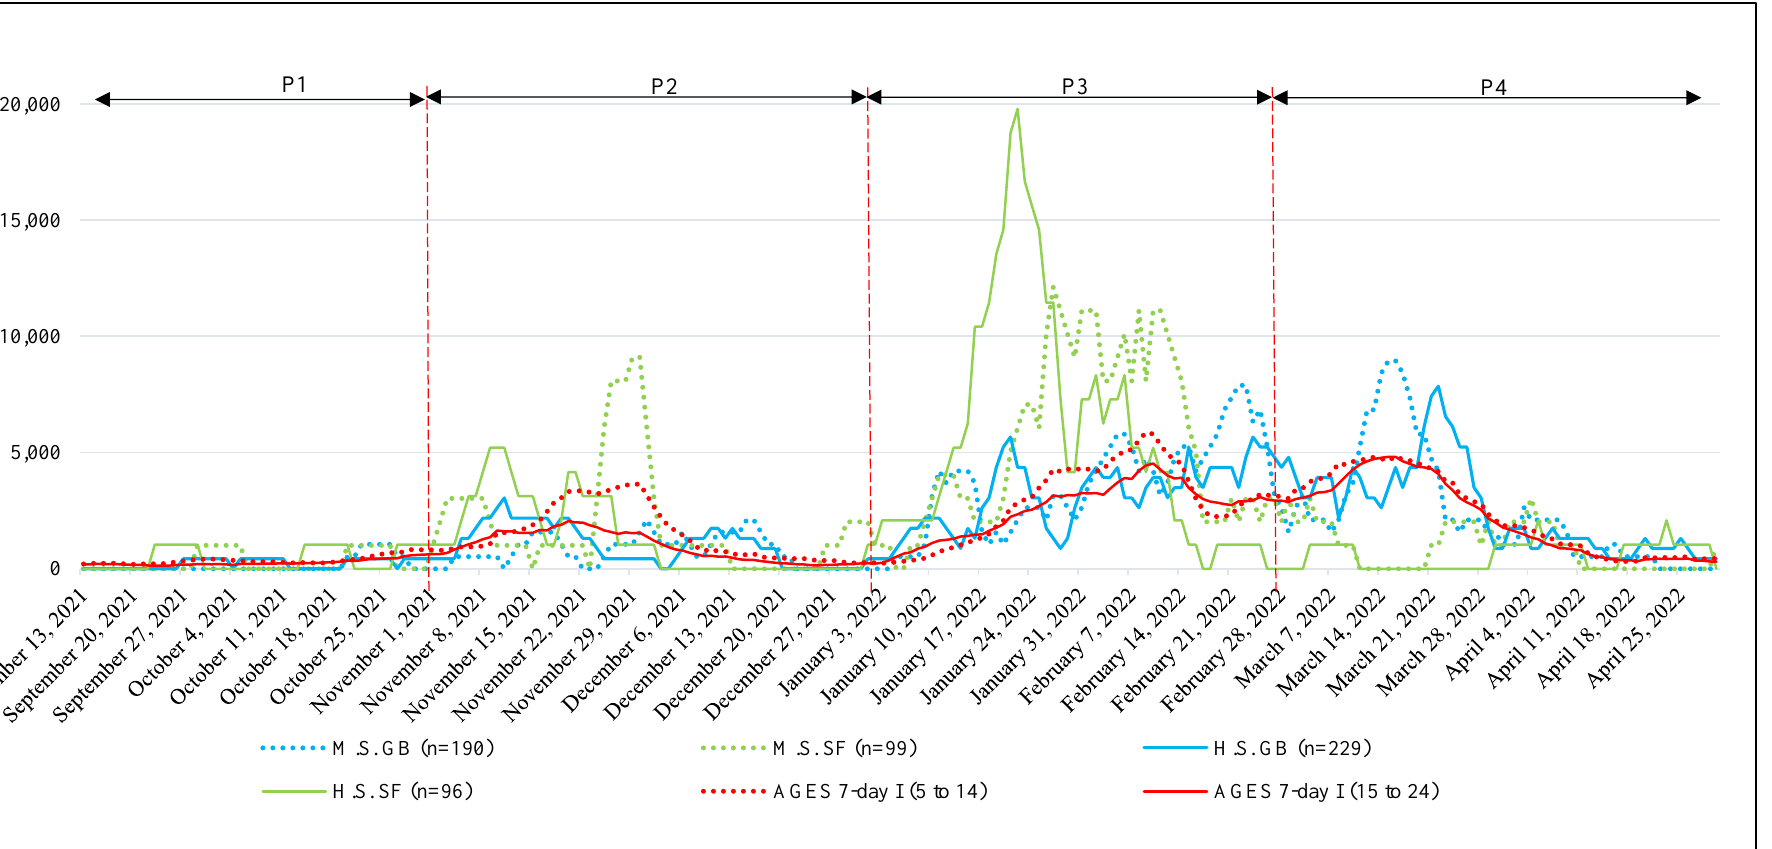
Figure 2. Differences in 7-day incidence of SARS-CoV-2 infections per 100,000 inhabitants in Carinthia (AUT) and among students of secondary school age with or without a sport focus. SARS-CoV-2 = severe acute respiratory syndrome coronavirus 2, P1 = period 1 (13 September 2021 to 31 October 2021), P2 = period 2 (1 November 2021 to December 2021), P3 = period 3 (1 January 2022 to 28 February 2022), P4 = period 4 (1 March 2022 to 30 April 2022), M.S. = middle school (children aged 13.1 ± 1.3 years old), H.S. = 4-year high school (children aged 16.9 ± 1.2 years old), GB = students in school classes in a general school branch, SF = students in school classes with sport focus, AGES = Austrian Agency for Health and Food Safety (https://covid19-dashboard.ages.at/, accessed on 5 September 2022), 7-day I (5 to 14) = 7 days incidence for SARS-CoV-2 infections per 100,000 inhabitants in Carinthia (AUT) for students aged 5 to 14 years, 7-day I (15 to 24) = 7 days incidence for SARS-CoV-2 infections per 100,000 inhabitants in Carinthia (AUT) for people aged 15 to 24 years, AUT = Austria.